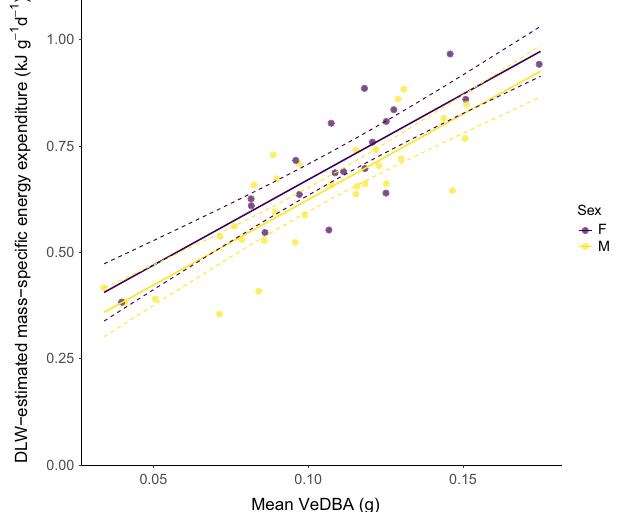
Figure 1. Vectoral dynamic body acceleration (VeDBA) reliably predicts daily energy expenditure (DEE) in Adélie penguins moving freely across different behavioural modes. (model equation: DEE = (0.27 ± 0.05) + (4.02 ± 0.38) mean VeDBA + (-0.05 ± 0.02)Sex, R 2 = 0.72, t 47 = 10.705, p <